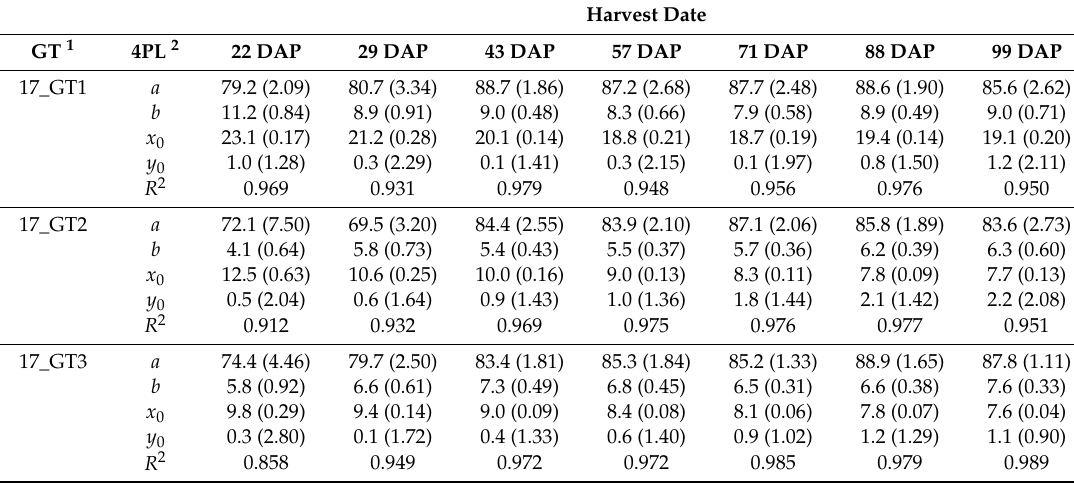
Table 2. Four-parameter logistic (4PL) regression parameter estimates for percentage germination in response to the number of days after imbibition for seeds harvested in 2017 across eight di ff erent harvest dates numbered by days after pollination (DAP). Standard errors are shown in